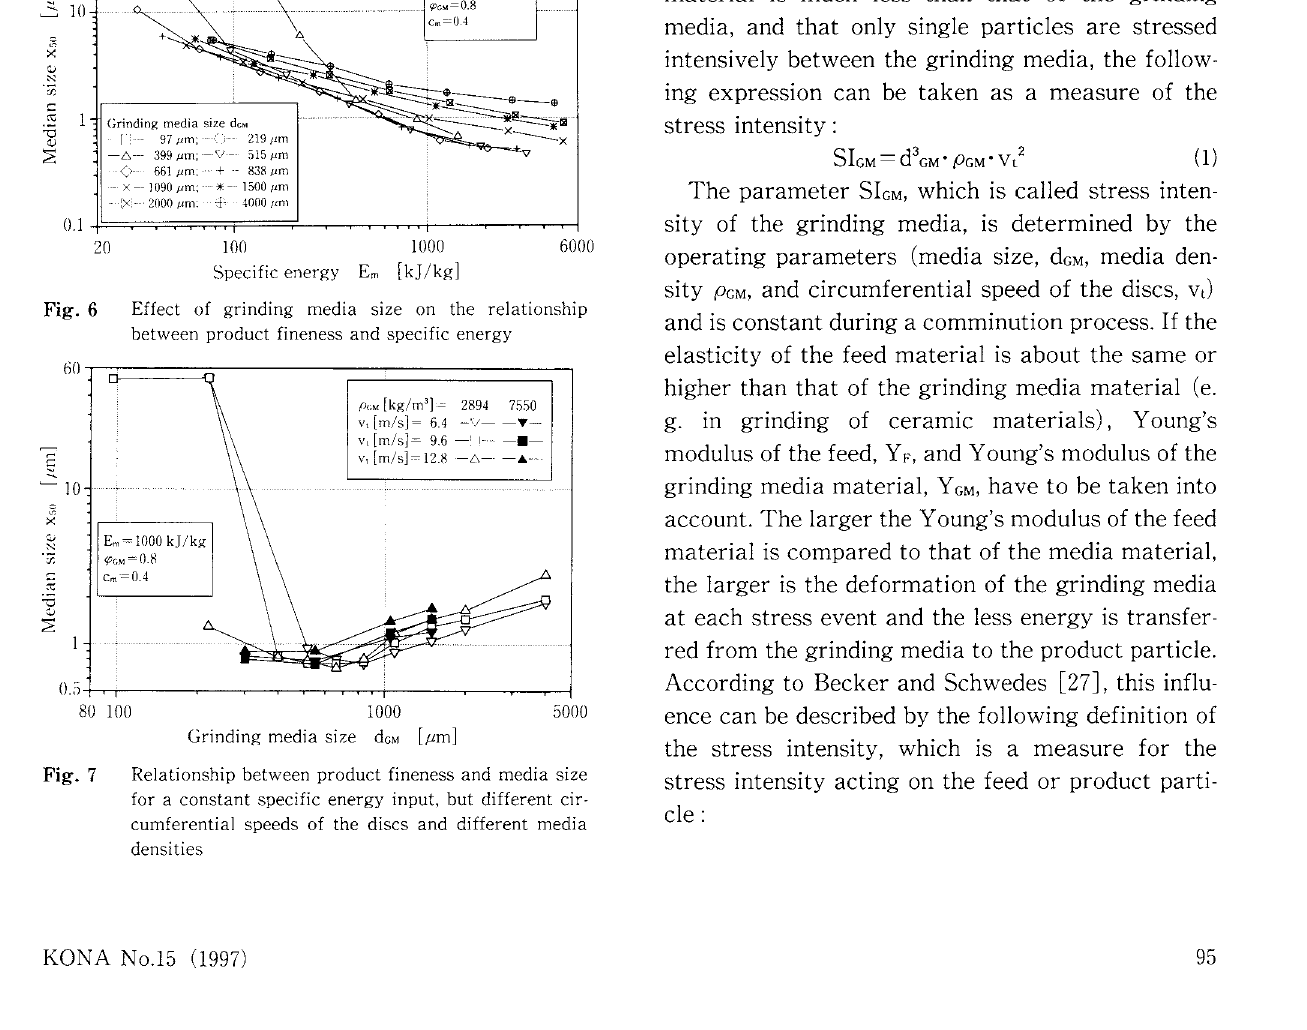
Effect of grinding media size on the relationship between product fineness and specific energy j[i=====q----------;:============:::;-1 60